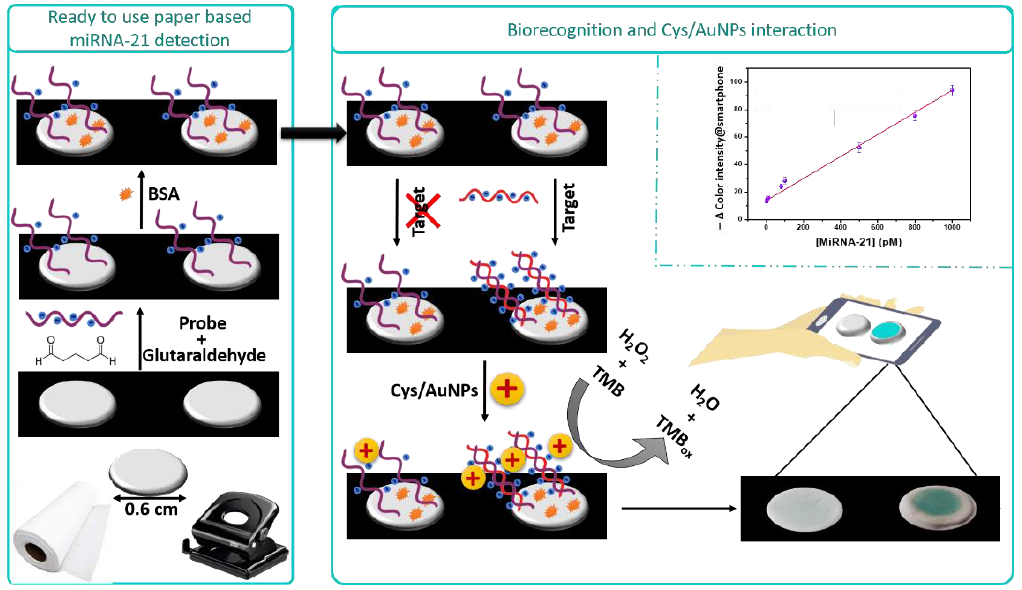
Scheme 1. Illustration of paper-based colorimetric biosensor based on the electrostatic interaction of positive Cys/AuNPs and phosphate groups of DNA backbone and its use for miRNA-21 detection using a